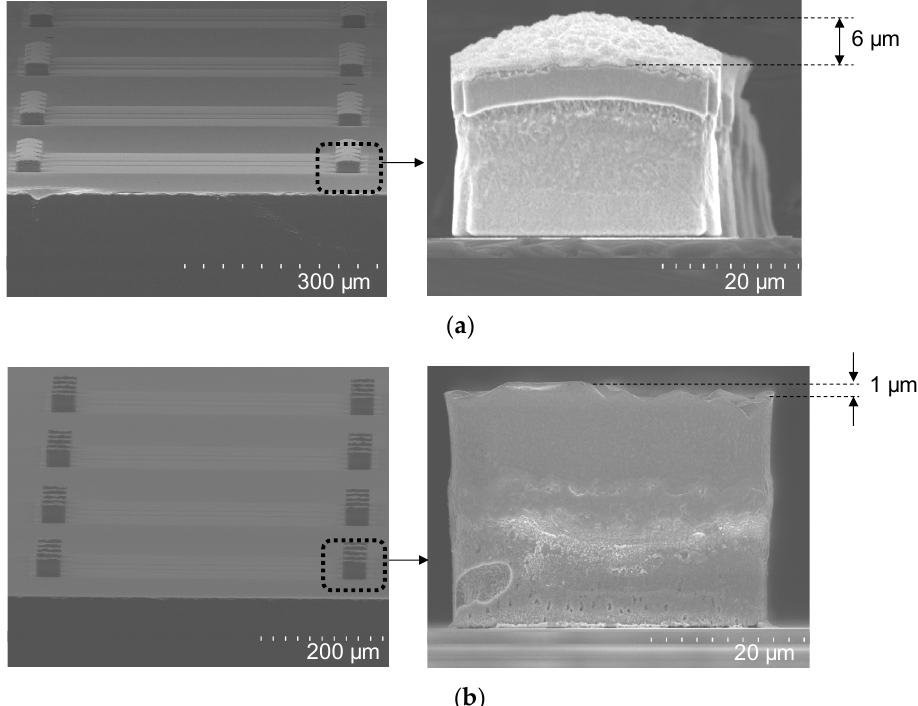
Figure 5. SEM images after formation of microbump (μ-bump) metal: ( a ) μ-bump metal that additives were used in in the Cu electroplating (EP) process; ( b ) μ-bump metal that additives were not used in in the Cu EP process.